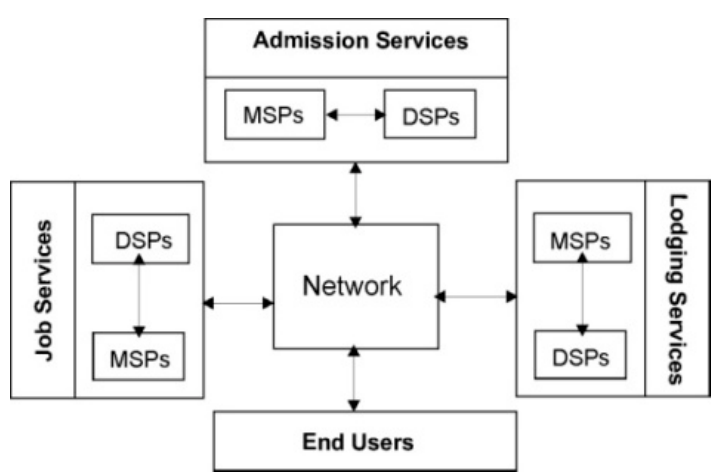
Figure 7. Data Mashup Service Network.